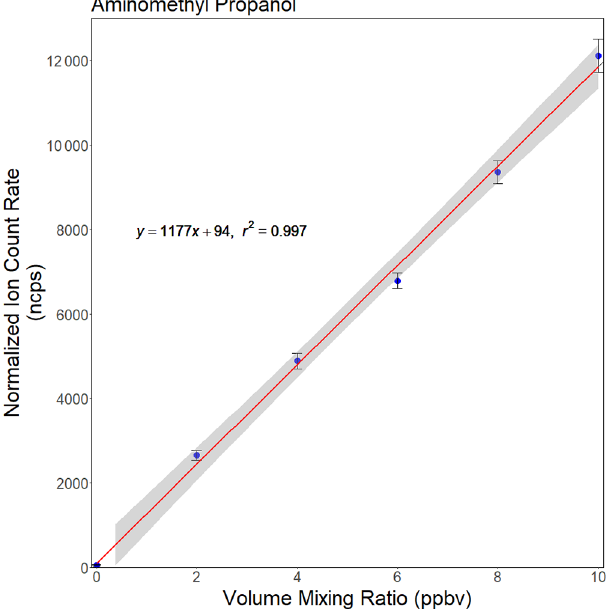
Figure 6. Calibration curve for 2-amino-2-methylpropan-1-ol (AMP). The PTR-ToF-MS instrument was operated in the H 3 O + mode (see